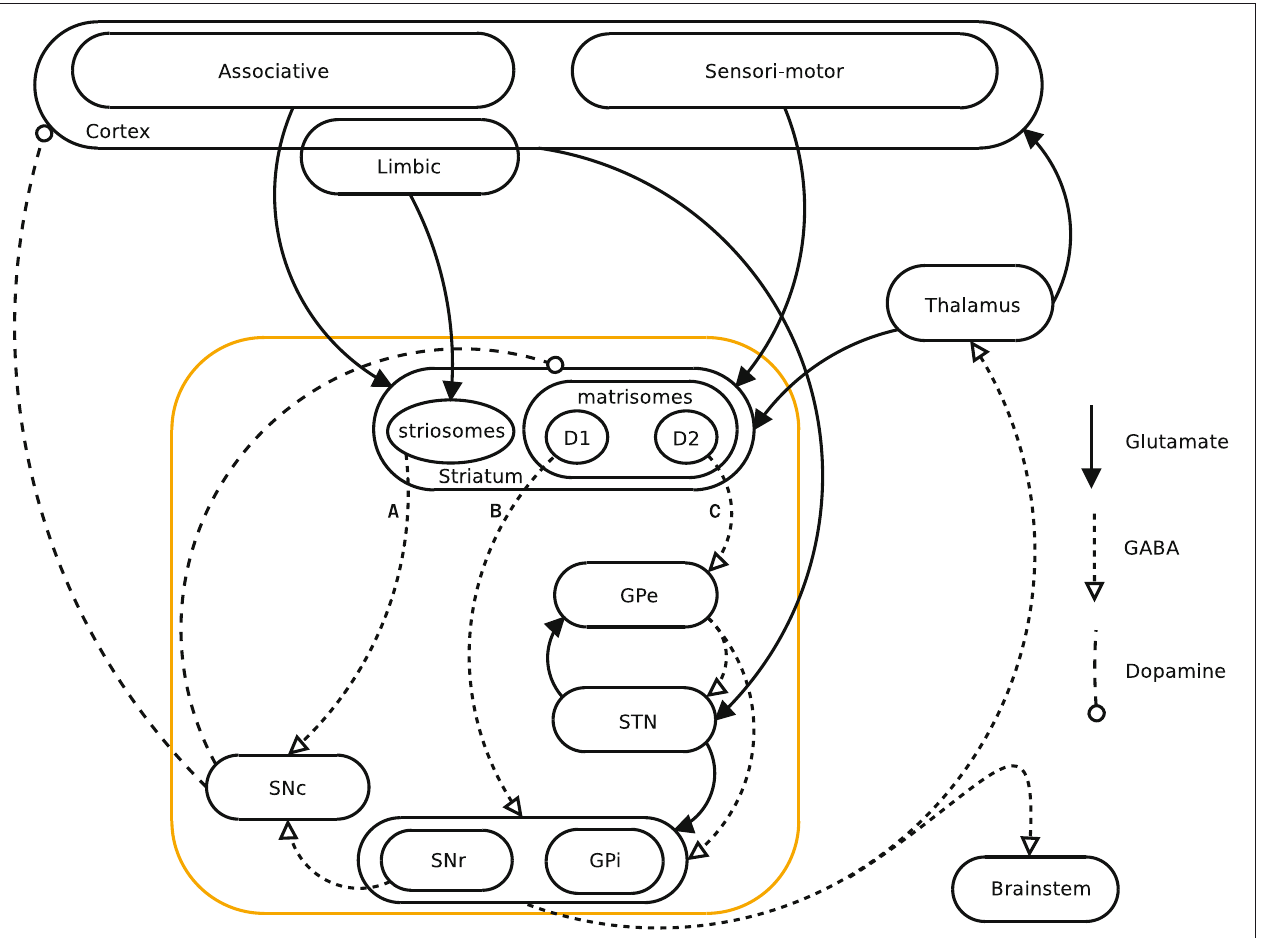
FIGURE 1 | Simplified diagram of the cortico-basal ganglia-thalamo-cortical loops. The Basal ganglia are shown in the orange box. We present a model investigating the three pathways A (striato-SNc: symbolizes the reward prediction system), B (direct/D1: maps onto the Go pathway), and C (indirect/D2: maps onto the NoGo pathway) originating in the